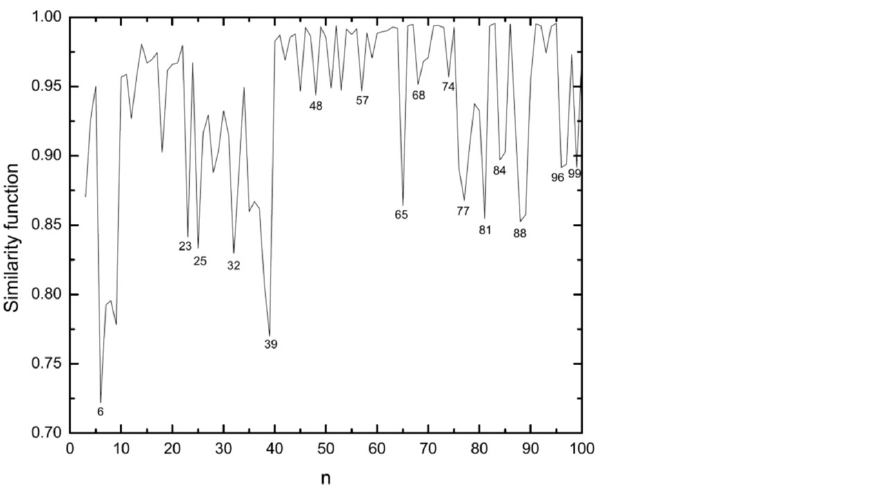
Figure 11. Similarity function of n atomic clusters when comparing with the clusters with n − 1 atoms. This can be used in identifying the structural changes due to a growth. The similarity function is based on the interatomic distances.